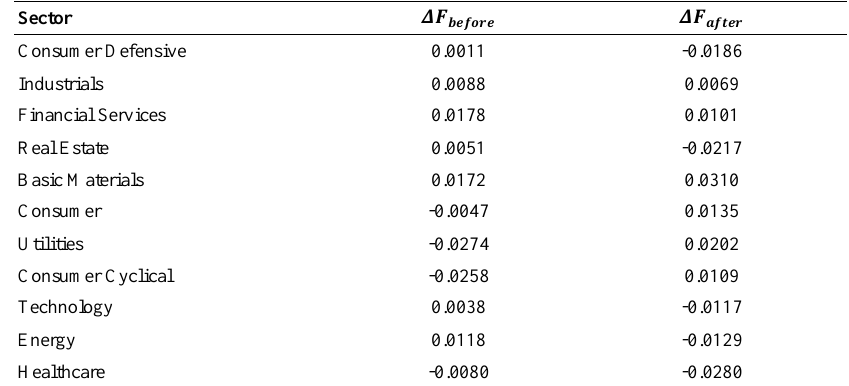
Table 2. The net information outflow for the sectors in BSE market, before and after COVID-19 outbreak